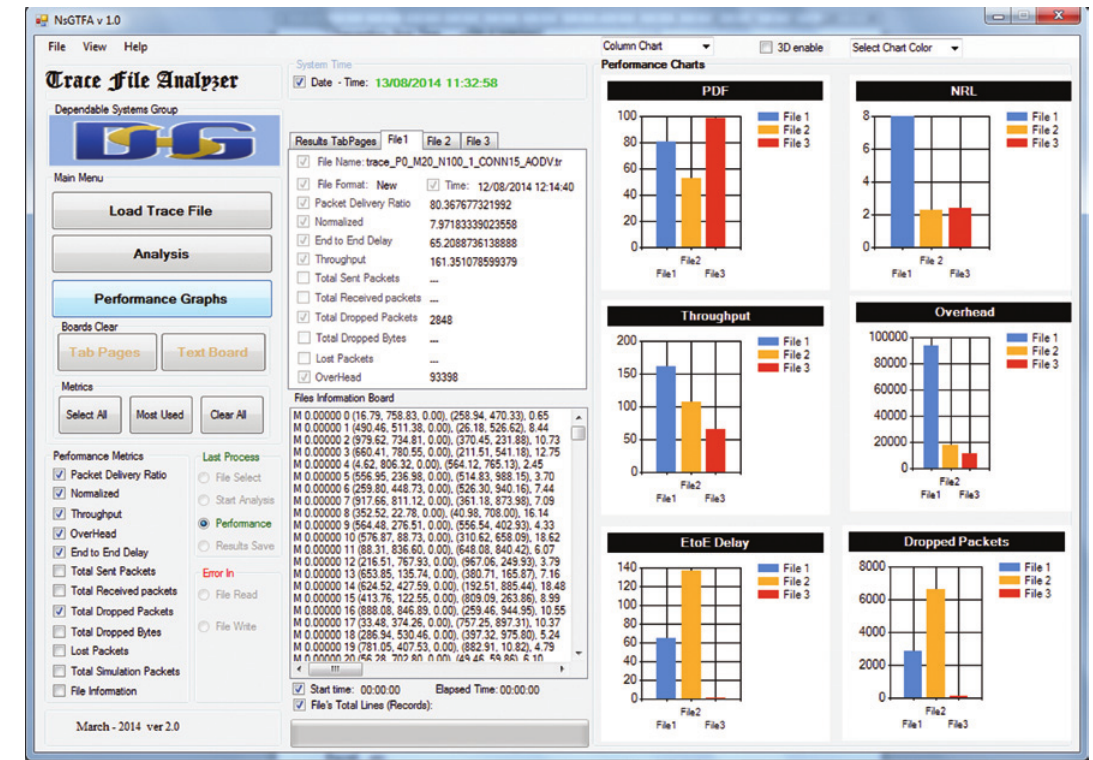
Figure 9. NsGTFA Appearance and